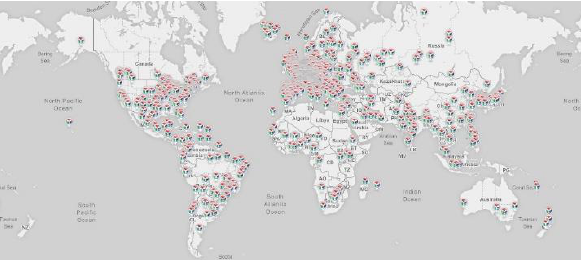
Figure 13. The map of Fab Labs over the world (FabLabs, n.d.).